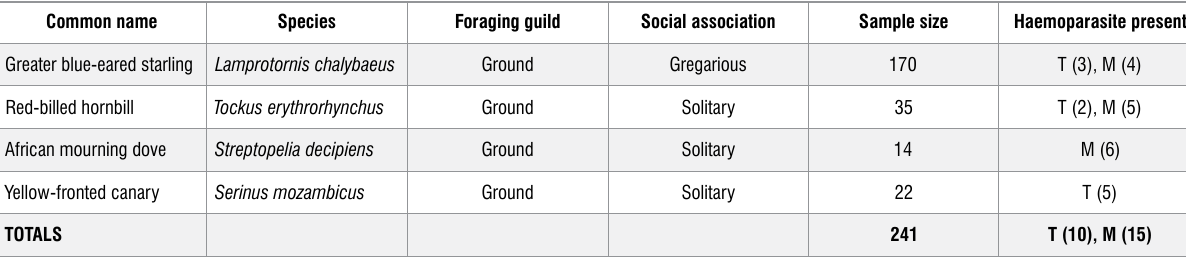
Birds with the highest infection prevalence, correlated with their habits Common